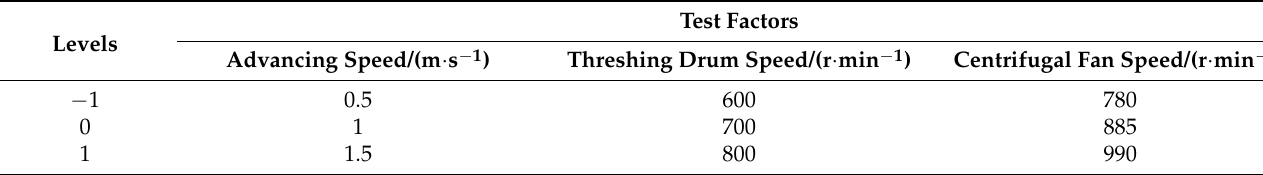
Table 2. Factor-level coding table.